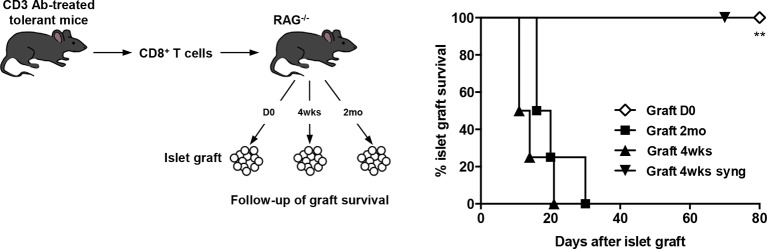
CD8+ T cell anergy depends on the presence of the antigens.CD8+ T lymphocytes were purified from CD3 Ab-treated tolerant C57BL/6 mice on day +100 post-transplant and were adoptively transferred into C57BL/6 Rag-/- mice (3x106/recipient, day 0). C57BL/6 Rag-/- recipients were transplanted with pancreatic islets from BALB/c donors either on day 0 (D0, n = 4) or 4 weeks (4wks, n = 4) or 2 months (2mo, n = 4) after cell transfer (**p<0.007). Syngeneic islets from C57BL/6 donors were grafted 4 weeks after cell transfer and were used as controls.